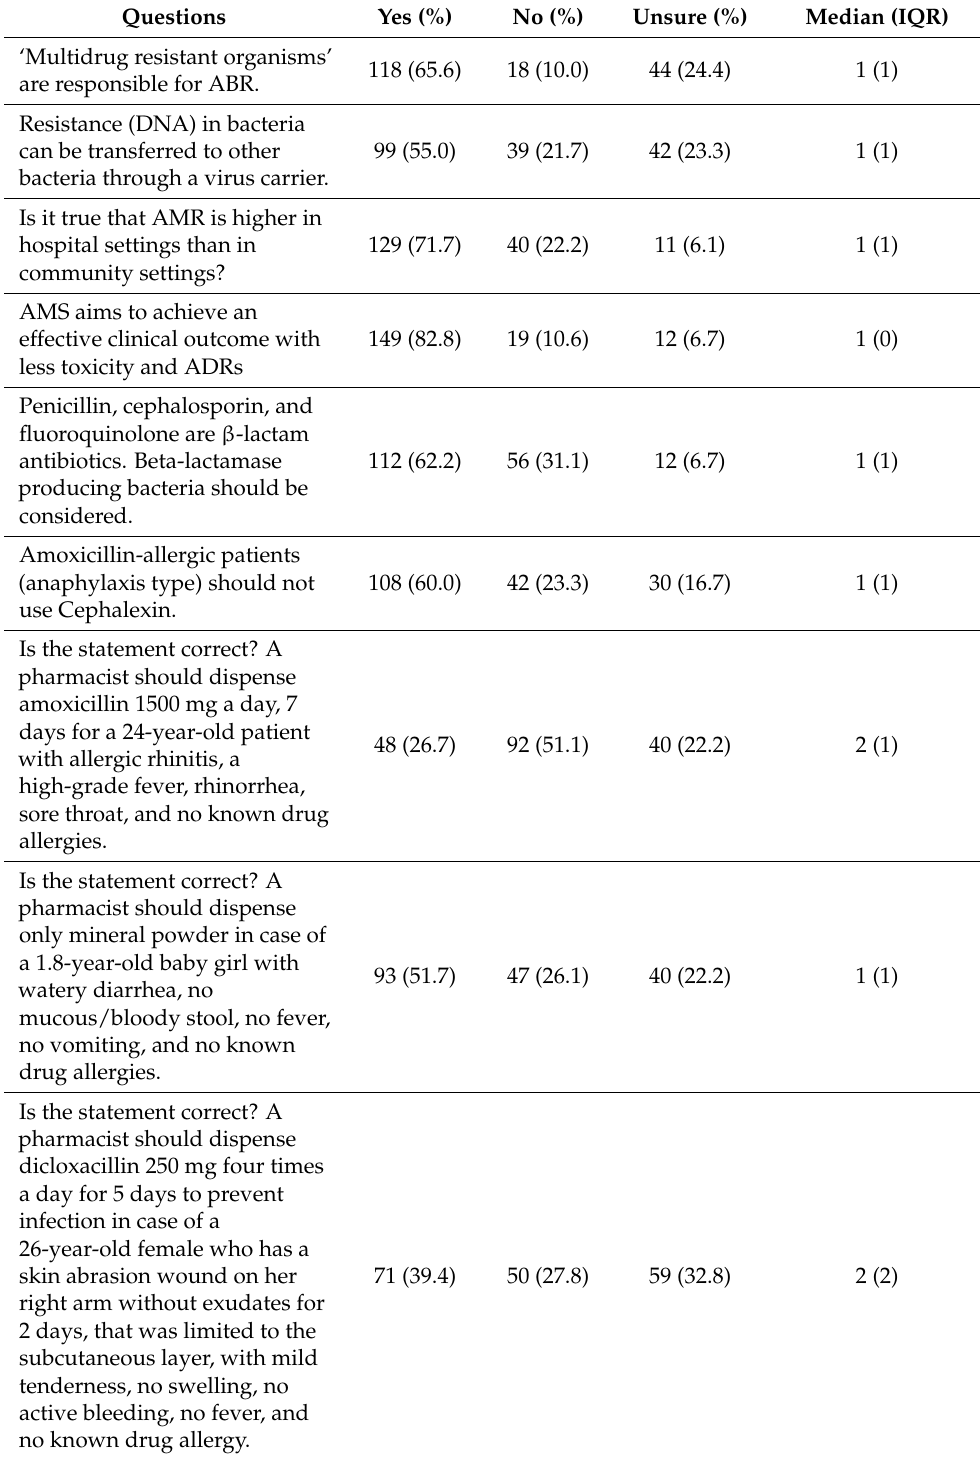
Table 2. Knowledge of respondents about